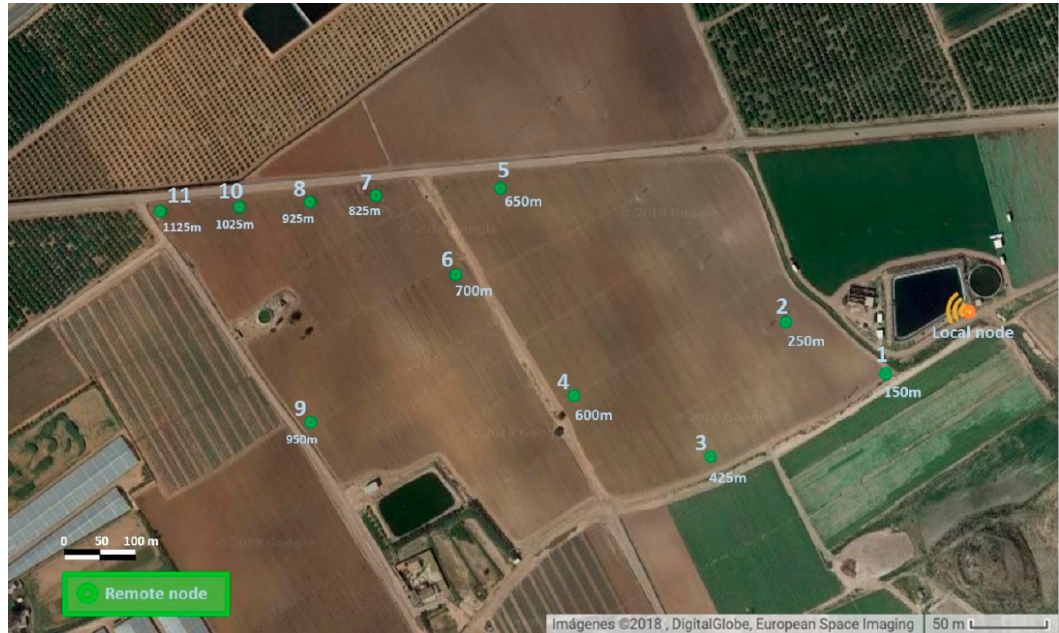
Figure 11. Aerial view of the location of the local control node and the remote capture nodes (source: DigitalGlobe, European Space Imaging).